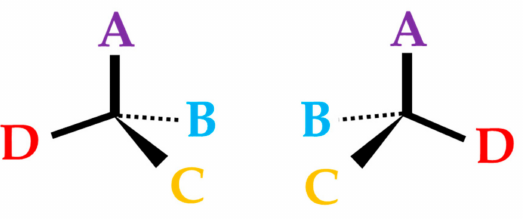
Figure 1. An example of non-superimposable mirror